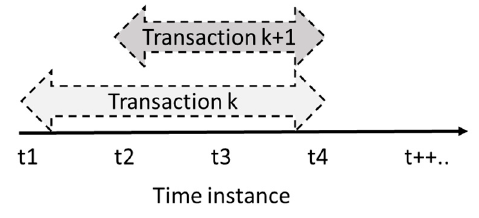
Figure 9. Multiple transactions at various time instances.